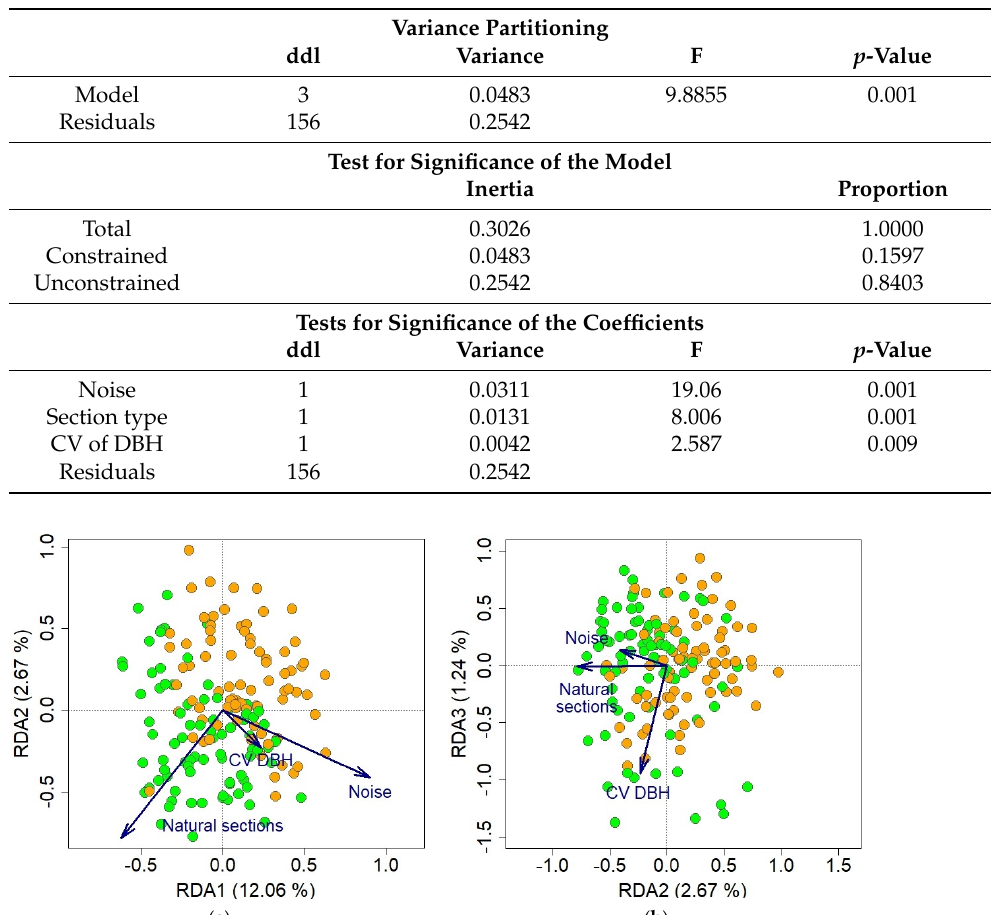
Table 2. Output summary of the canonical redundancy analysis of bird communities (formula: matrix of bird observations ~ noise + section type + CV of DBH).